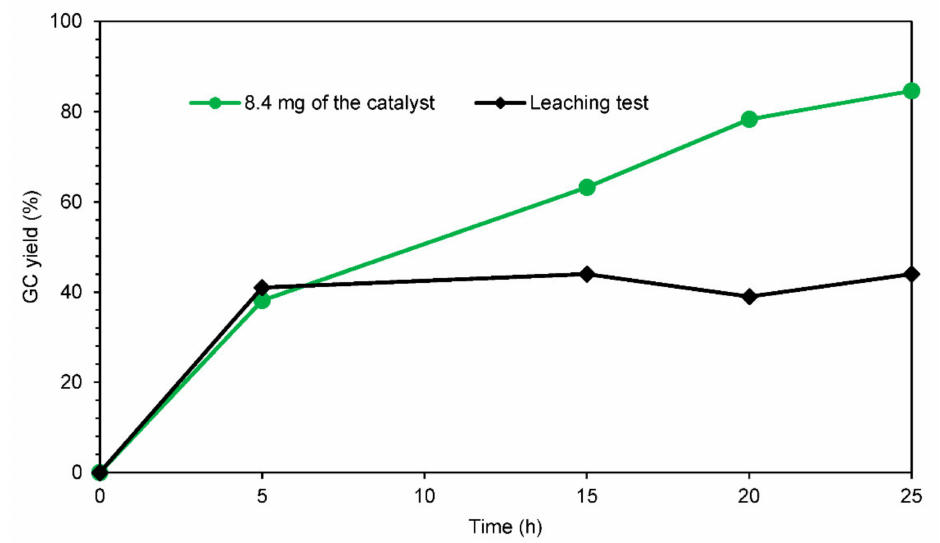
Figure 14. Leaching test for the Cu 1 Ce 0.7 Si